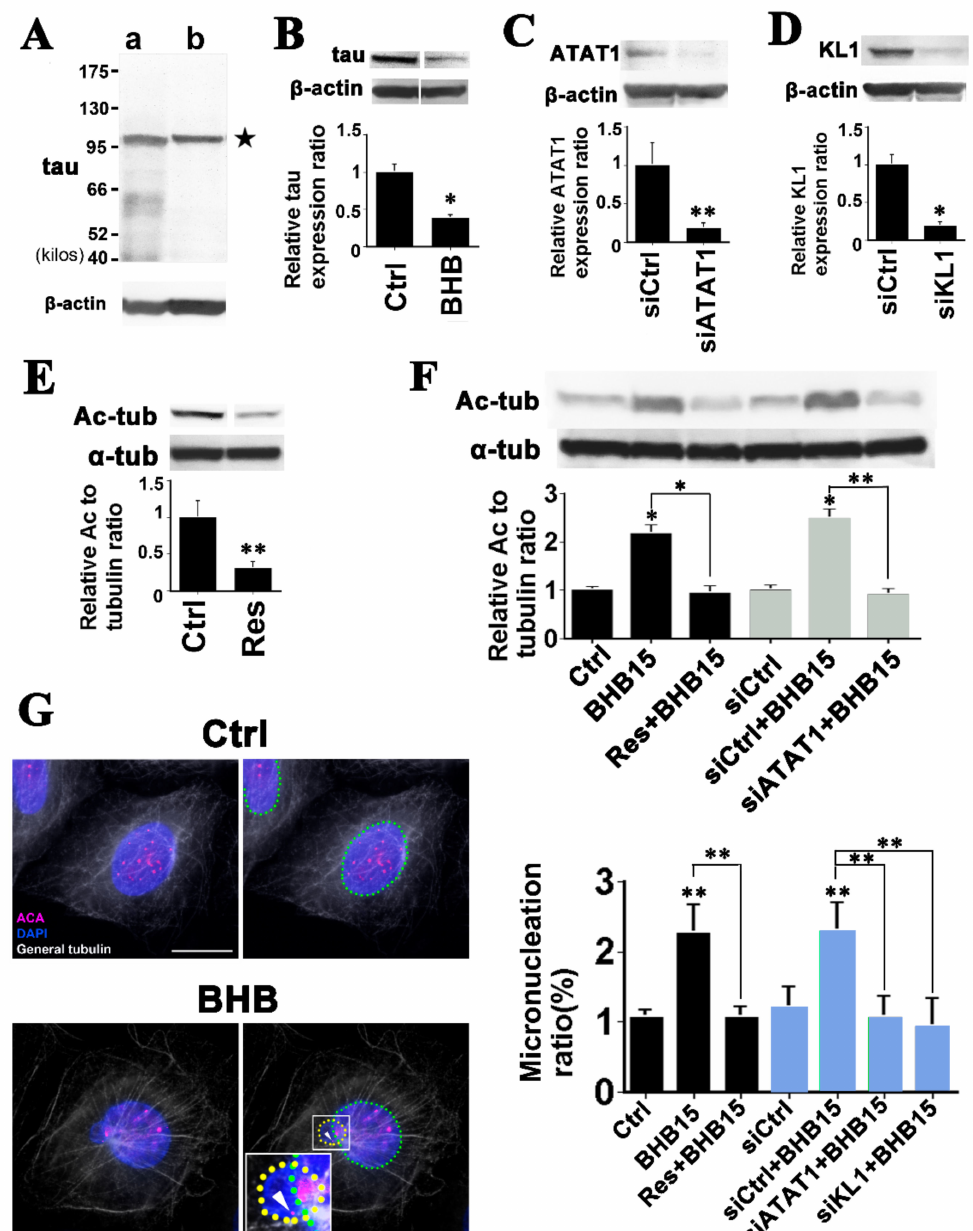
Figure 4. BHB induces whole chromosome micronucleation via upregulated microtubule acetylation in HCECs. ( A ) Tau protein expression in HCECs. Whole cell lysates of HCT116 cells ( a ) and HCECs ( b ) were subjected to immunoblotting with anti-tau antibody. HCT116 cells were used as a positive control and expressed various tau species including Big tau of near 95 kDa in size. HCECs showed only Big tau expression. The star denotes Big tau which has been shown to be an inhibitor of KL1 [19]. ( B ) Treatment of HCECs with 15 mM BHB for three days reduced the tau levels significantly, by around 70% (graph). ( C ) Effects of siATAT1 in HCECs. A more than 80% reduction was achieved. ( D ) Effects of the KL1 knockdown on HCECs. A more than 80% reduction was achieved. ( E ) Effects of resveratrol (Res) on microtubule acetylation in HCECs. HCECs were treated with 75 µ M resveratrol, cultured for three days, and analyzed by immunoblotting. Compared with the controls, an approximately 70% reduction in the Ac to tubulin rate was evident in the resveratrol-treated cells. ( F ) Effects of resveratrol and siATAT1 on BHB-induced microtubule hyperacetylation. In the first experiments, HCECs were treated with 15 mM BHB, further treated with 75 µ M resveratrol, and cultured for three days. Significant increases in tubulin acetylation were detected in response to BHB, which were inhibited by resveratrol (graph; black bars). In the second set of